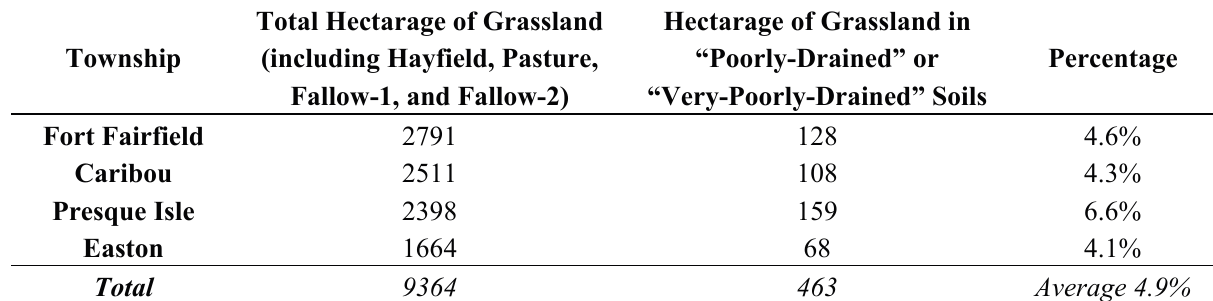
Table 2. Hectarage of grasslands with “poorly-drained” or “very-poorly-drained” soils.